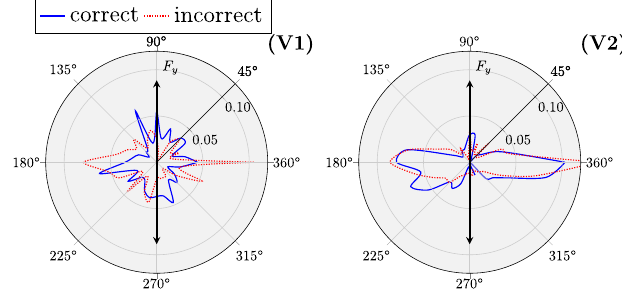
FIG. 6. Polar distributions of saccadic directions with regards to vector fields V1 and V2. The direction of the nonzero field vector F y is highlighted.